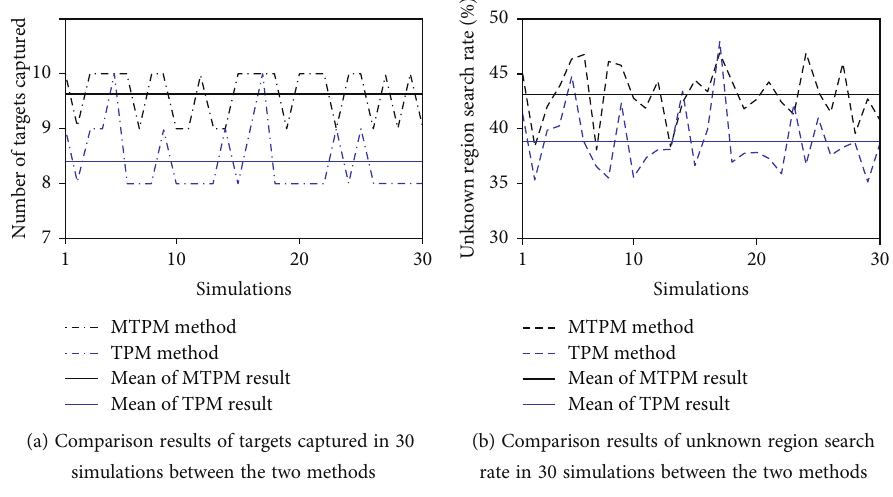
Figure 8: Comparison results in 30 simulations between the two